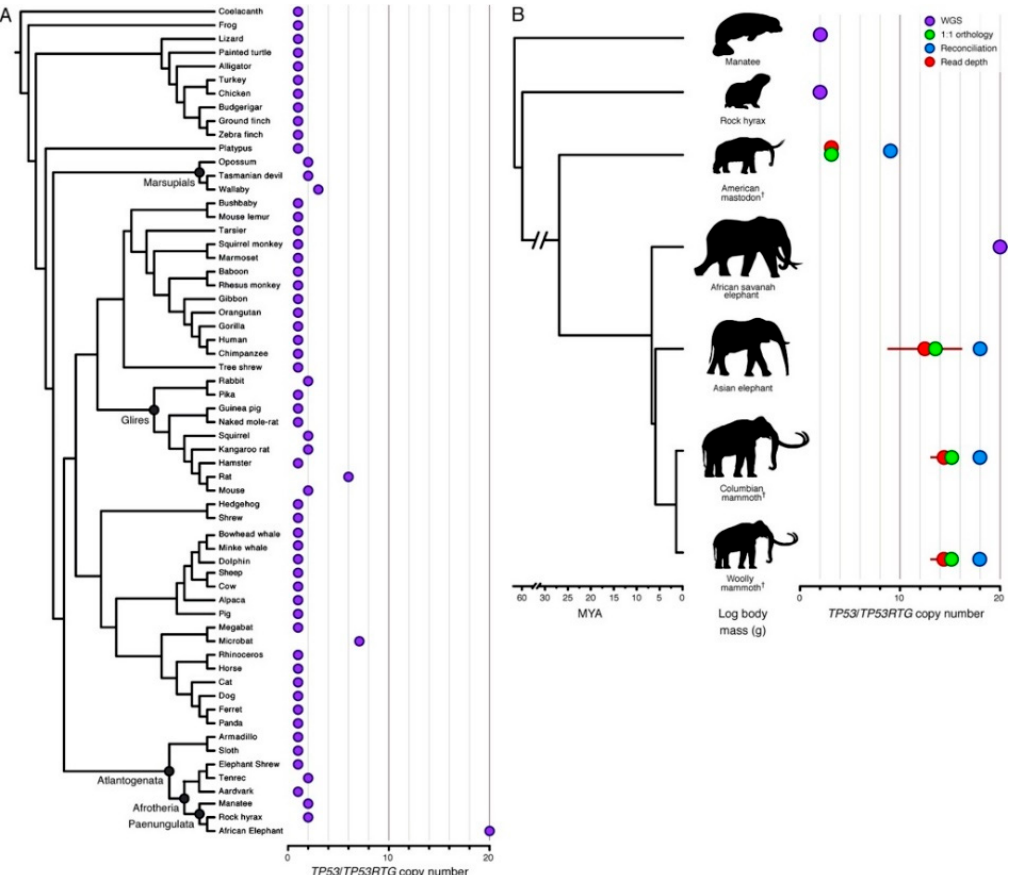
Figure 3. Expansion of the TP53RTG gene repertoire in Proboscideans. ( A ) TP53 copy number in 61 Sarcopterygian (Lobe-finned fish) genomes. Clade names are shown for lineages in which the genome encodes more than one TP53 gene or pseudogene. ( B ) Estimated TP53 / TP53RTG copy number inferred from complete genome sequencing data (WGS, purple), 1:1 orthology (green), gene tree reconciliation (blue), and normalized read depth from genome sequencing data (red). Whiskers on normalized read depth copy number estimates show the 95% confidence interval of the estimate. Reproduced with permission from “ TP53 copy number expansion is associated with the evolution of increased body size and an enhanced DNA damage response in elephants”, Sulak et al., 2016. https: // doi.org / 10.7554 /